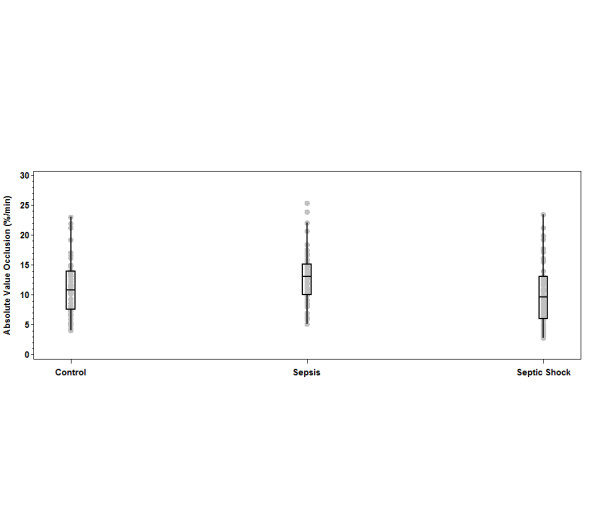
Differences in initial, ischemic and recovery slopes stratified by sepsis severity. Ischemic slope. The top and bottom lines of the box are the 25th and 75th percentiles. The middle line is the median. The whiskers extend to the last data point within 1.5 quartile ranges of the box. The gray dots are the individual observed data points.